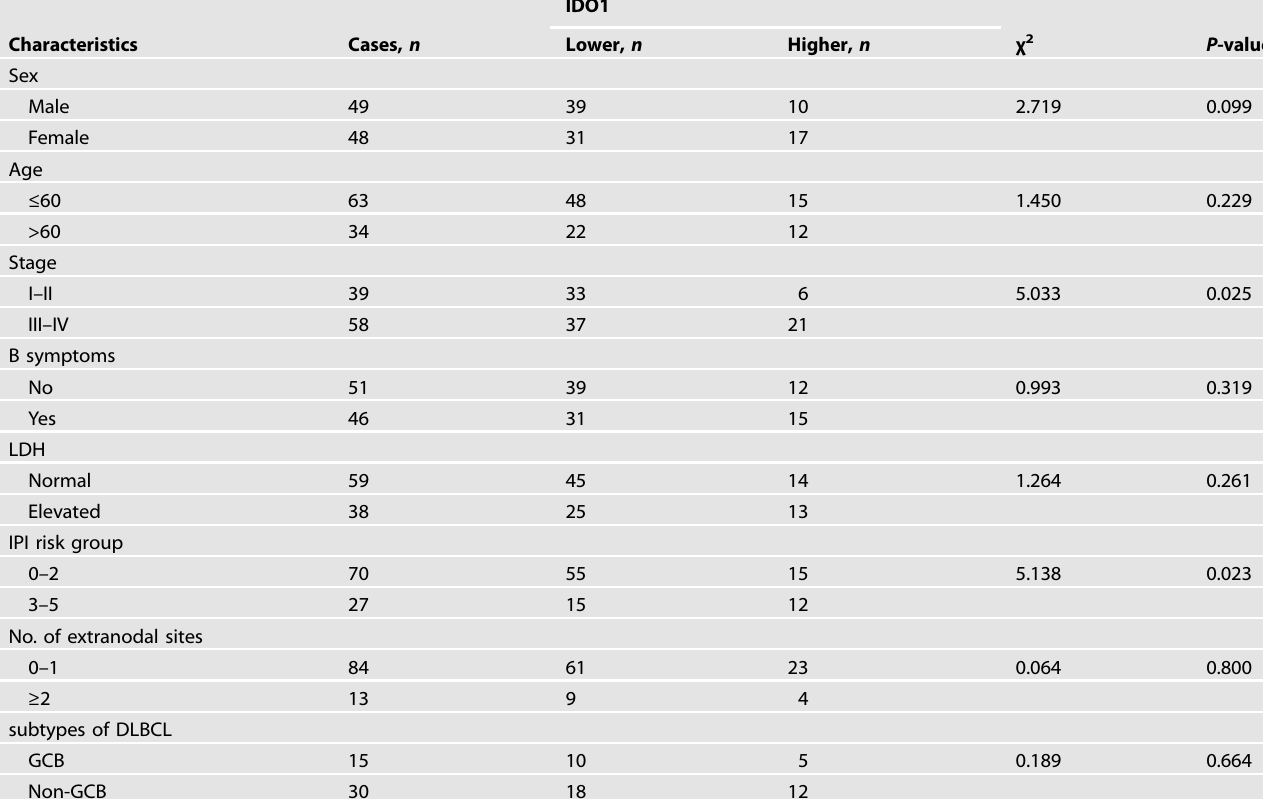
Table 1. Correlation between IDO1 expression and clinicopathological features of 97 DLBCL